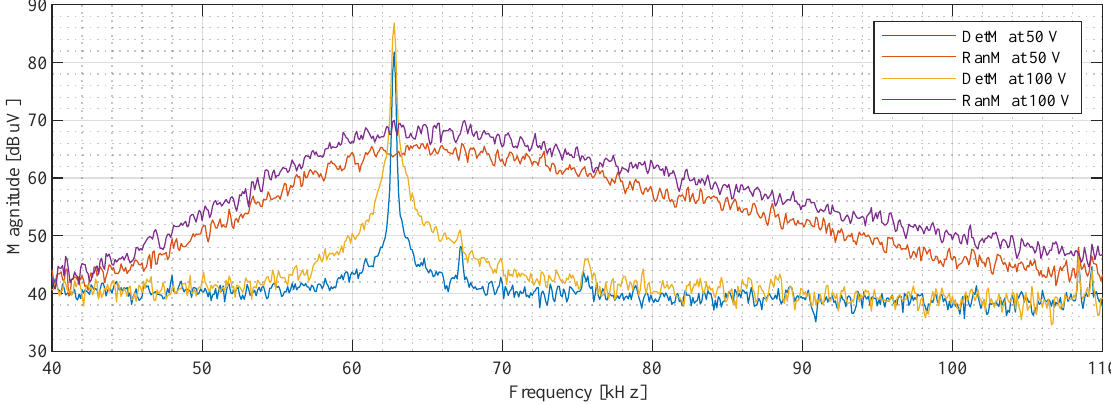
Figure 8. The frequency spectrum of DC/DC converter measured at grid terminal (point 1) for DetM and RanM. ( a ) DBPSK